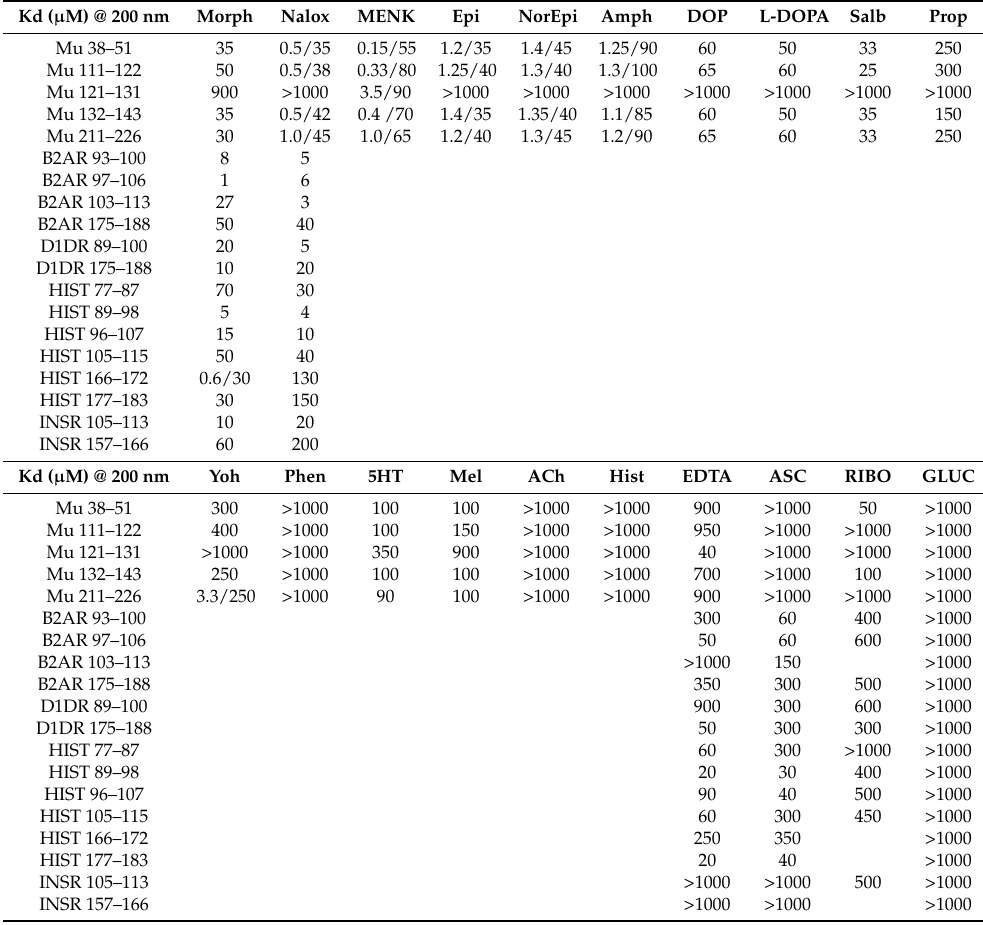
Table 2. Binding constants (in micromoles) of various bioactive compounds for the receptor peptides listed in Table